Question: Sum up the contents of this chart in one sentence.
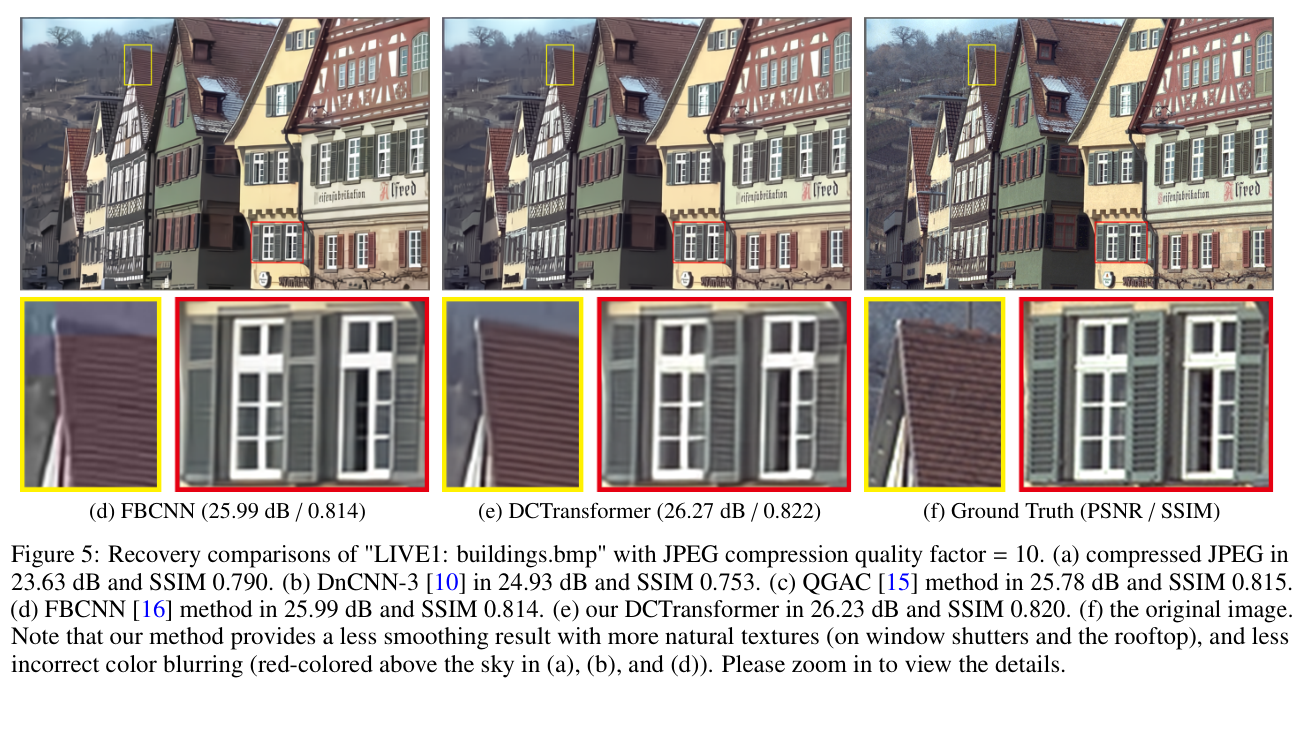
Answer: presents another comparison of the results for artifact removal. The channel residual refers to the difference between the recovered images and the corresponding ground truth. We convert the recovered results to YCbCr colorspace and present the residual of each channel separately. Through this example, we highlight that the proposed DCT domain method is able to handle color components quite well. It is worth emphasizing that since our method generates upsampled chrominance components in the DCT domain, the recovery result from our method shows a more consistent color with the ground truth, i.e. less red-colored blurring in the area of the sky. That also demonstrates the design of luminance-chrominance alignment has an advantage in eliminating large area color artifacts, which eventually produces a more visually pleasing restoration.